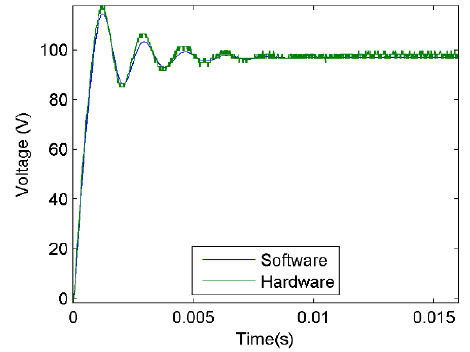
Figure 21. BCE voltage response.